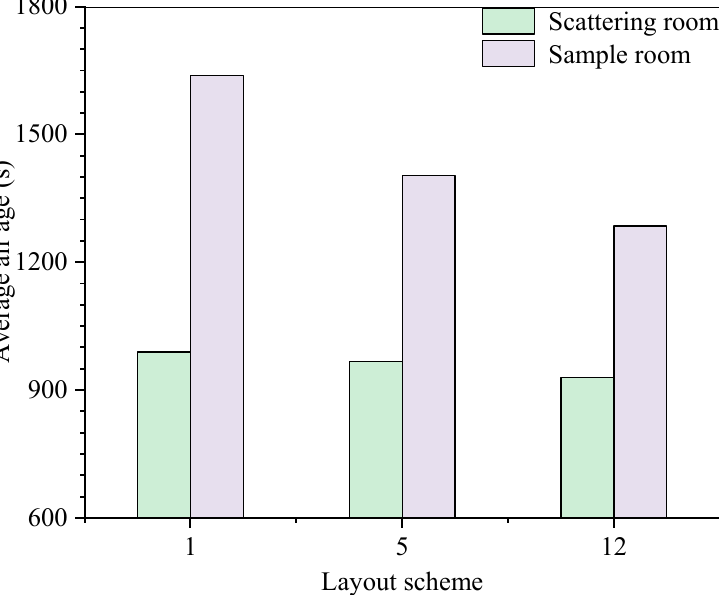
Figure 7. Air age contour of the same cross height section at three layout schemes (The scattering room z = 1.6 m and the sample room z = 2.4 m). ( a ) Air age of layout scheme 1. ( b ) Air age of layout scheme 5. ( c ) Air age of layout scheme 12.